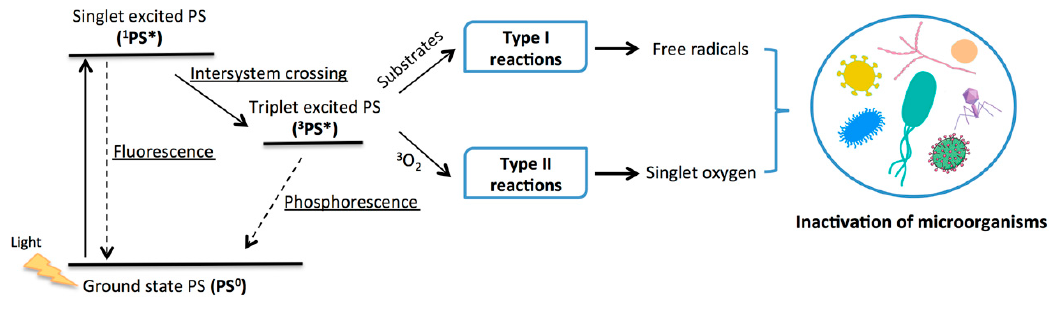
Figure 1. Illustration of the photochemical mechanisms of different reactive oxygen species (ROS) produced during photodynamic action.